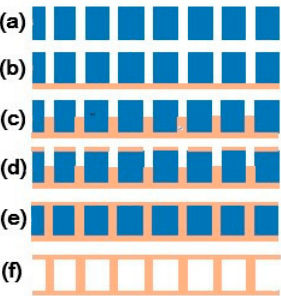
Figure 8. Three-dimensional (3D) inductor manufacturing steps: ( a ) TSVs were etched and a SiO 2 insulation layer was deposited. ( b ) The adhesion layer (Cr, 30 nm) and seed layer (Cu, 300 nm) were sputtered and electroplated copper covered the TSVs. ( c ) Electroplated copper was grown in TSVs. ( d ) The copper layer was sputtered on the top side. ( e ) The TSVs were fully filled and ( f ) the silicon substrate was removed.